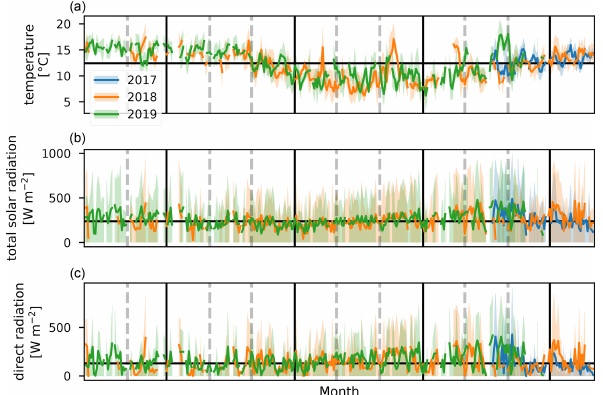
Figure 5. Daily average values of temperature, total solar radiation, and direct radiation (a–c) for 2017, 2018, and 2019 (blue, orange, and green, respectively). Shaded areas behind the curve show the diel interquartile range. The horizontal black line corresponds to the median daily average over the complete measurement period. Vertical gray dashed lines indicate the end of a month, and vertical black lines separate the DJF, MAM, JJA, and SON